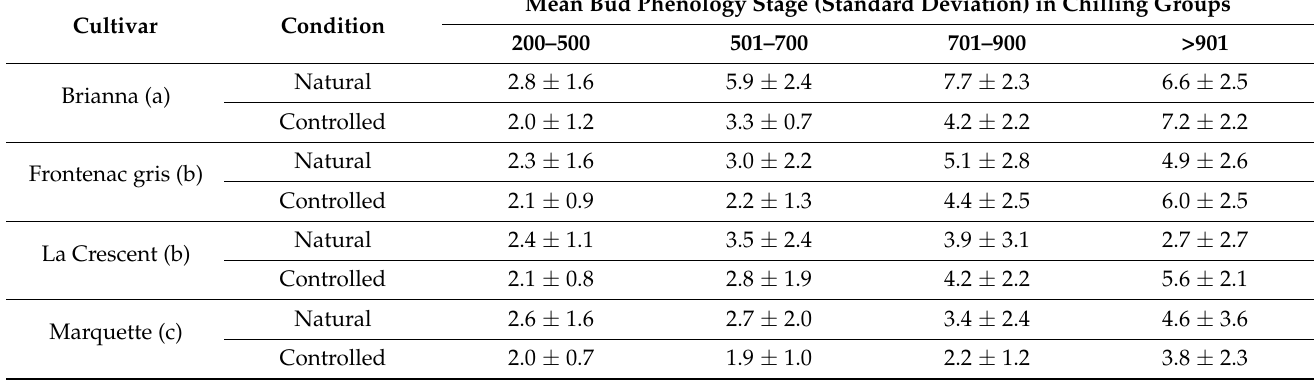
Mean phenology stage ± standard error for three years of measure. Differing letters in parenthesis after cultivar indicate phenology stage, in response to chilling hour accumulation, was significantly different between cultivars.